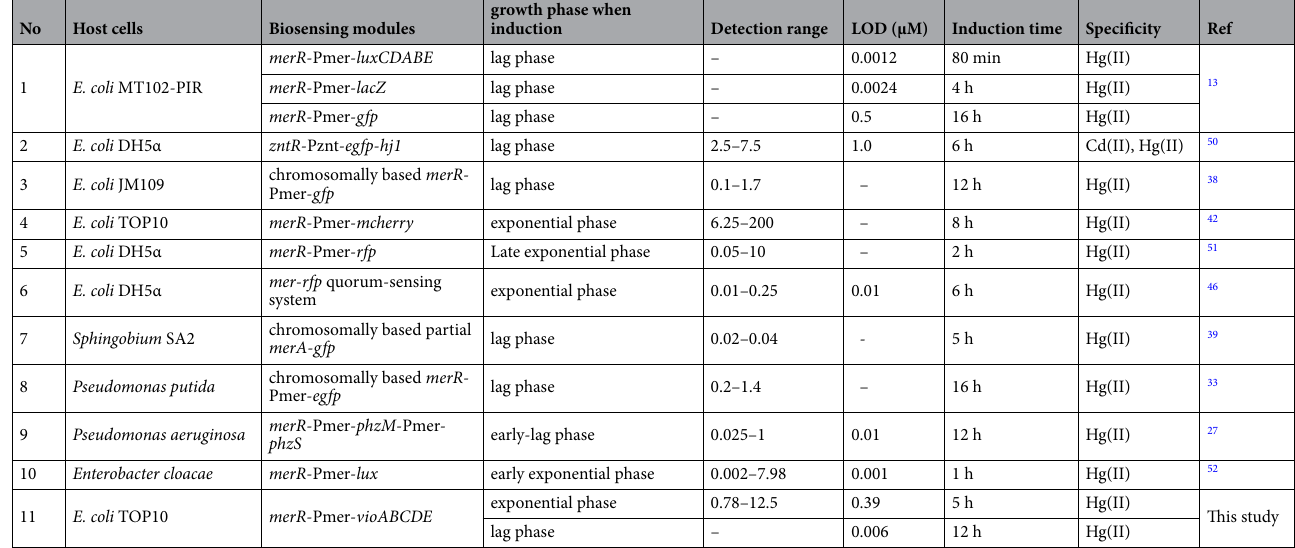
Table 2. Comparison of developed whole-cell biosensors for the detection of bioavailable Hg(II). LOD: limit of detection, lux: luciferase, lacZ: β-galactosidase, gfp: green fluorescent protein, zntR: